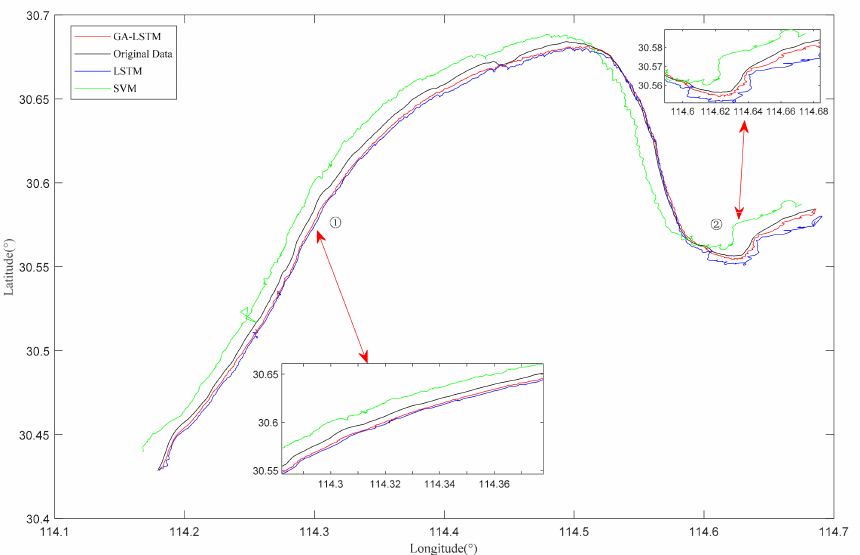
Figure 8. Comparison of experimental results of ship-1 trajectory